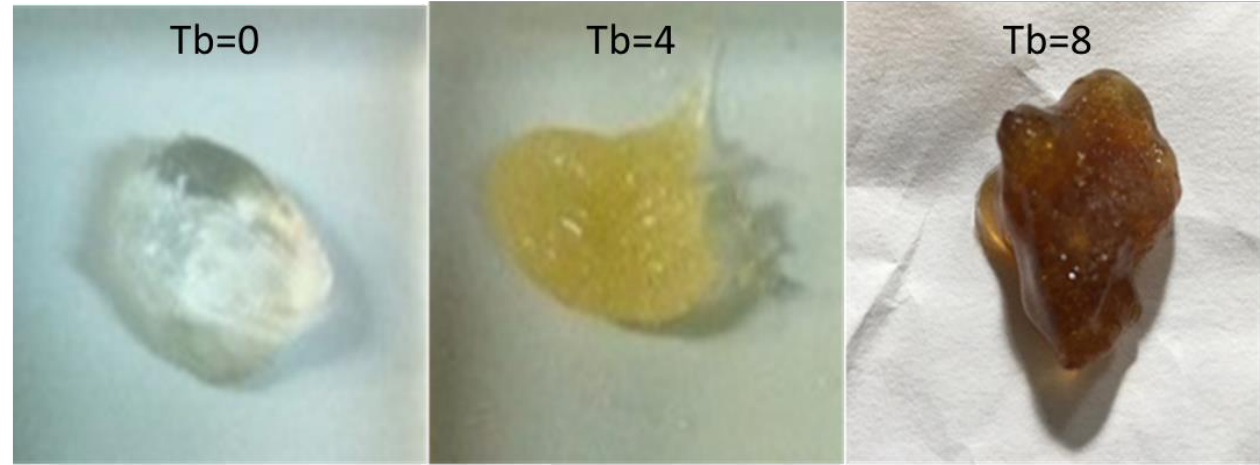
Figure 1. Example of different turbidity levels on hydrogel color.